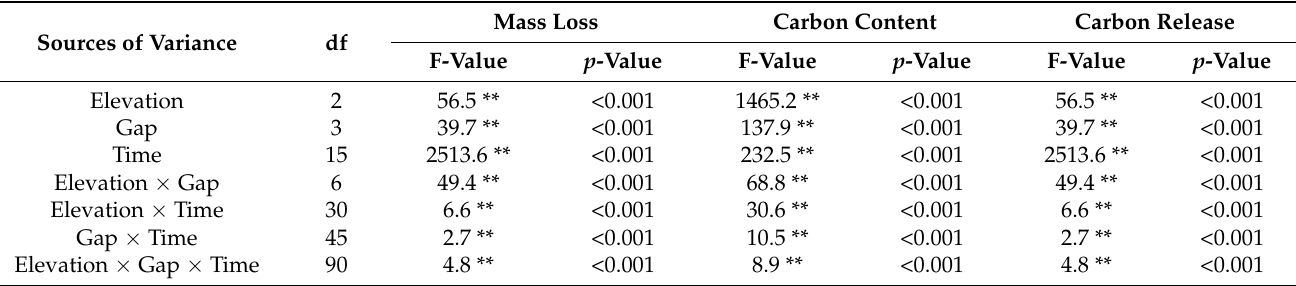
Table 2. Results (F-values) of linear mixed effects models testing the effects of elevation (3000, 3300, 3600 m), gap size (large, middle, small), decomposition time (sampled times) and their interactions on mass loss and carbon content and release in in decomposing A. faxoniana litter. ** p <